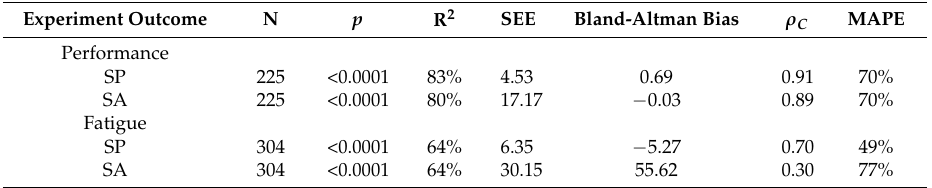
Figure 6. Linear regression and Bland-Altman plots between dyna-torque and the predicted MC torque. ( A ) Linear regression of peak dyna-torque and the MC-torque SP with 95% confidence bands; ( B ) Linear regression scatter plots of average dyna-torque and the MC-torque SA with 95% confidence bands; ( C ) Bland-Altman plots of peak dyna-torque and the Predicted MC-torque SP; ( D ) Bland-Altman plots of average dyna-torque and the Predicted MC-torque SA. Derivation of these variables has been described in the text. Table 3. Muscle performance and muscle fatigue analysis for signal peak and signal average relationships of dyna-torque and predicted MC